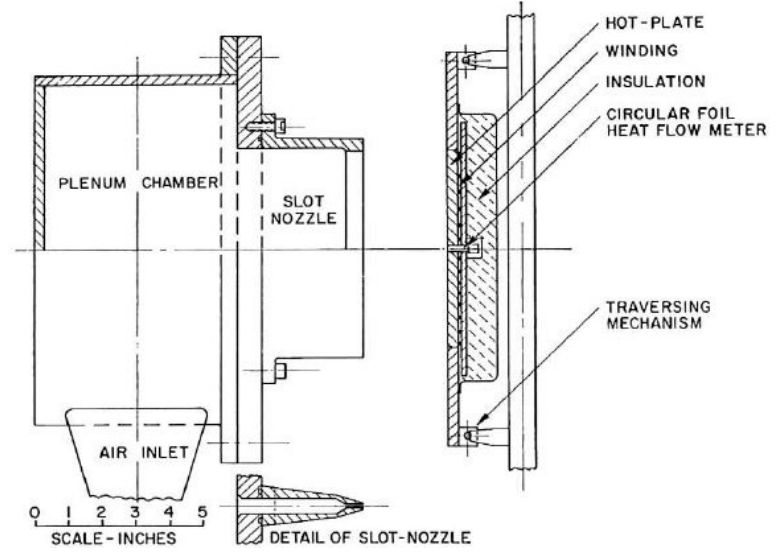
Figure 3. Experimental test apparatus [12].